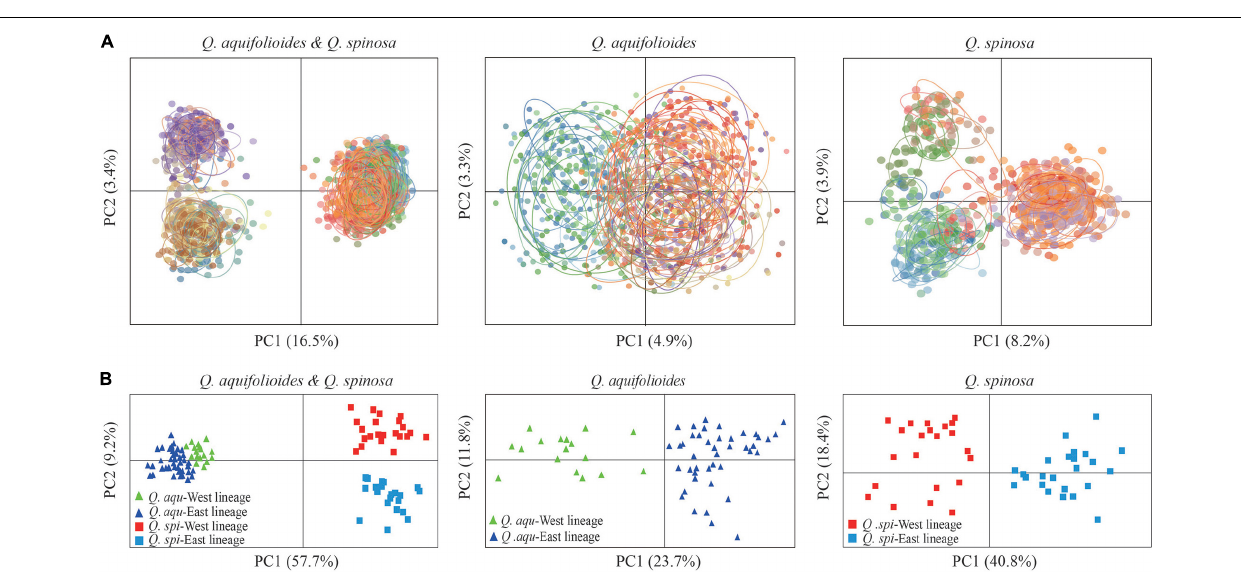
FIGURE 4 | Genetic covariance of Q. aquifolioides and Q. spinosa . (A) Principal component analysis (PCA) plots based on genetic covariance among individuals. The first two principal components (PCs) are shown; (B) principal coordinate analysis (PCoA) plots of the first two components based on genetic covariance among